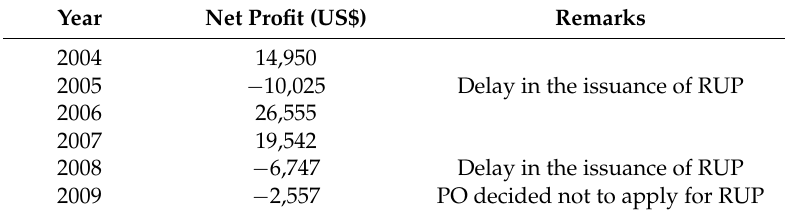
Table 3. NPPFDRC net profit during the period of timber harvesting operation